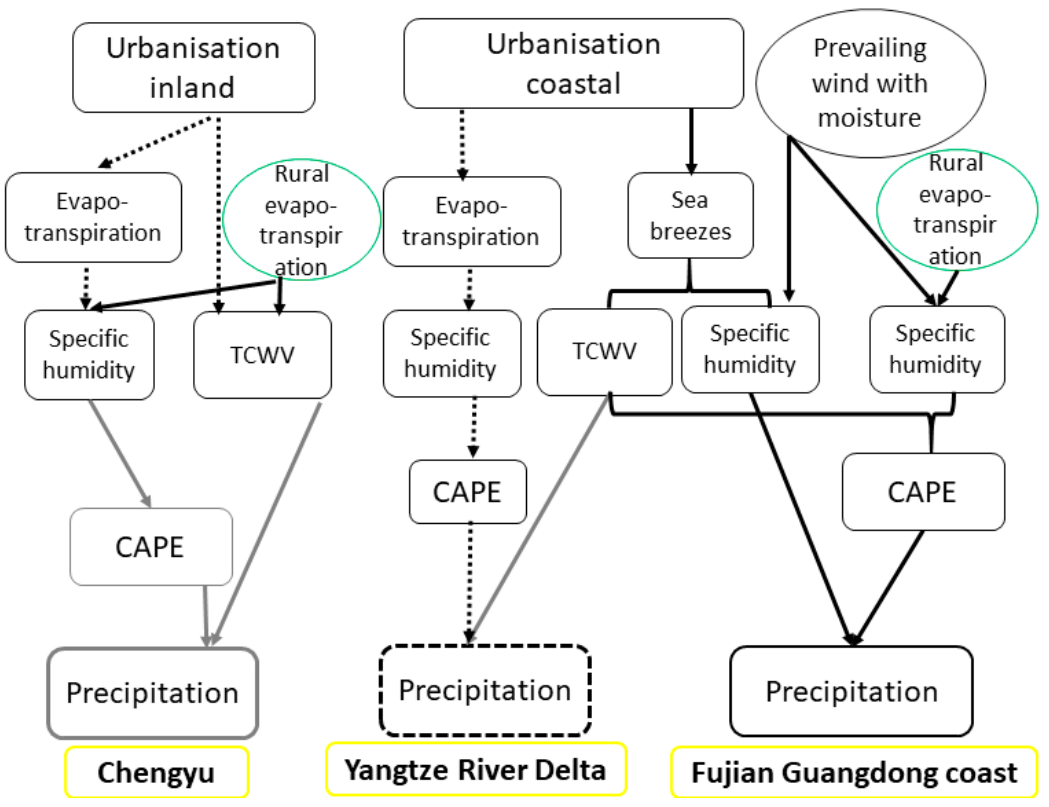
Figure 7. Conceptualization of differentiated urbanization effects on warm season precipitation in South China. The connections marked by solid lines indicate increasing with urbanization, while those marked by dot lines indicate decreasing with urbanization, those grey lines indicate negligible trend with urbanization. CAPE stands for a CAPE trend ≥ 5 (J·kg − 1 ·year − 1 ).